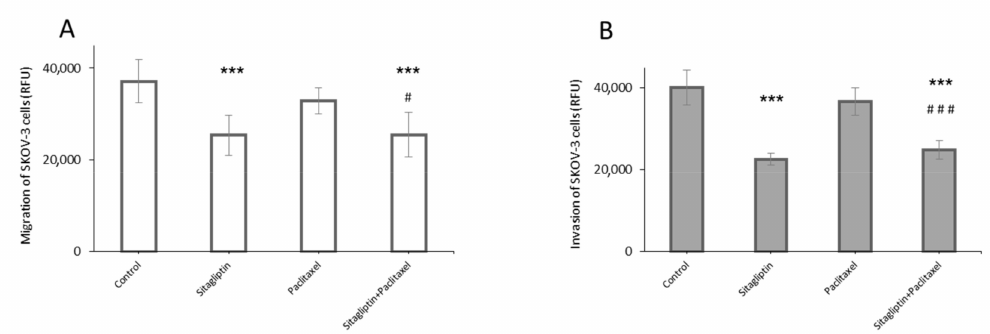
Figure 3. Sitagliptin e ff ects on migration and invasion of ovarian cancer cells. SKOV-3 cell line was stimulated for 24 h with sitagliptin (50 µ M) and paclitaxel (10 nM) or both for transwell migration assay ( A ) and transwell invasion assay ( B ). Relative fluorescence unit (RFU) was measured. Mean values ± SD are shown. n = 6 per group. *** p < 0.001 control vs. di ff erent conditions. # p < 0.05, ### p < 0.001 paclitaxel vs. sitagliptin + paclitaxel group. One-way ANOVA followed with Tukey’s post hoc